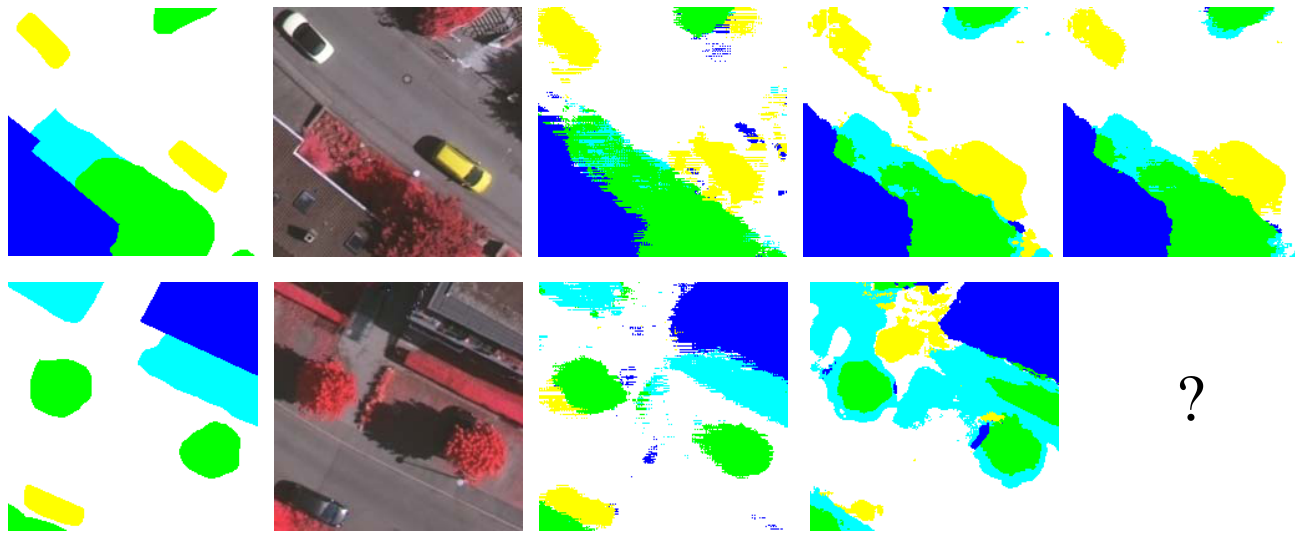
Figure 3. Two examples of classification results for complementary (top) and conflicting (bottom) scenes. From left to right: ground truth, input image CNN labelling, combined classifier labelling